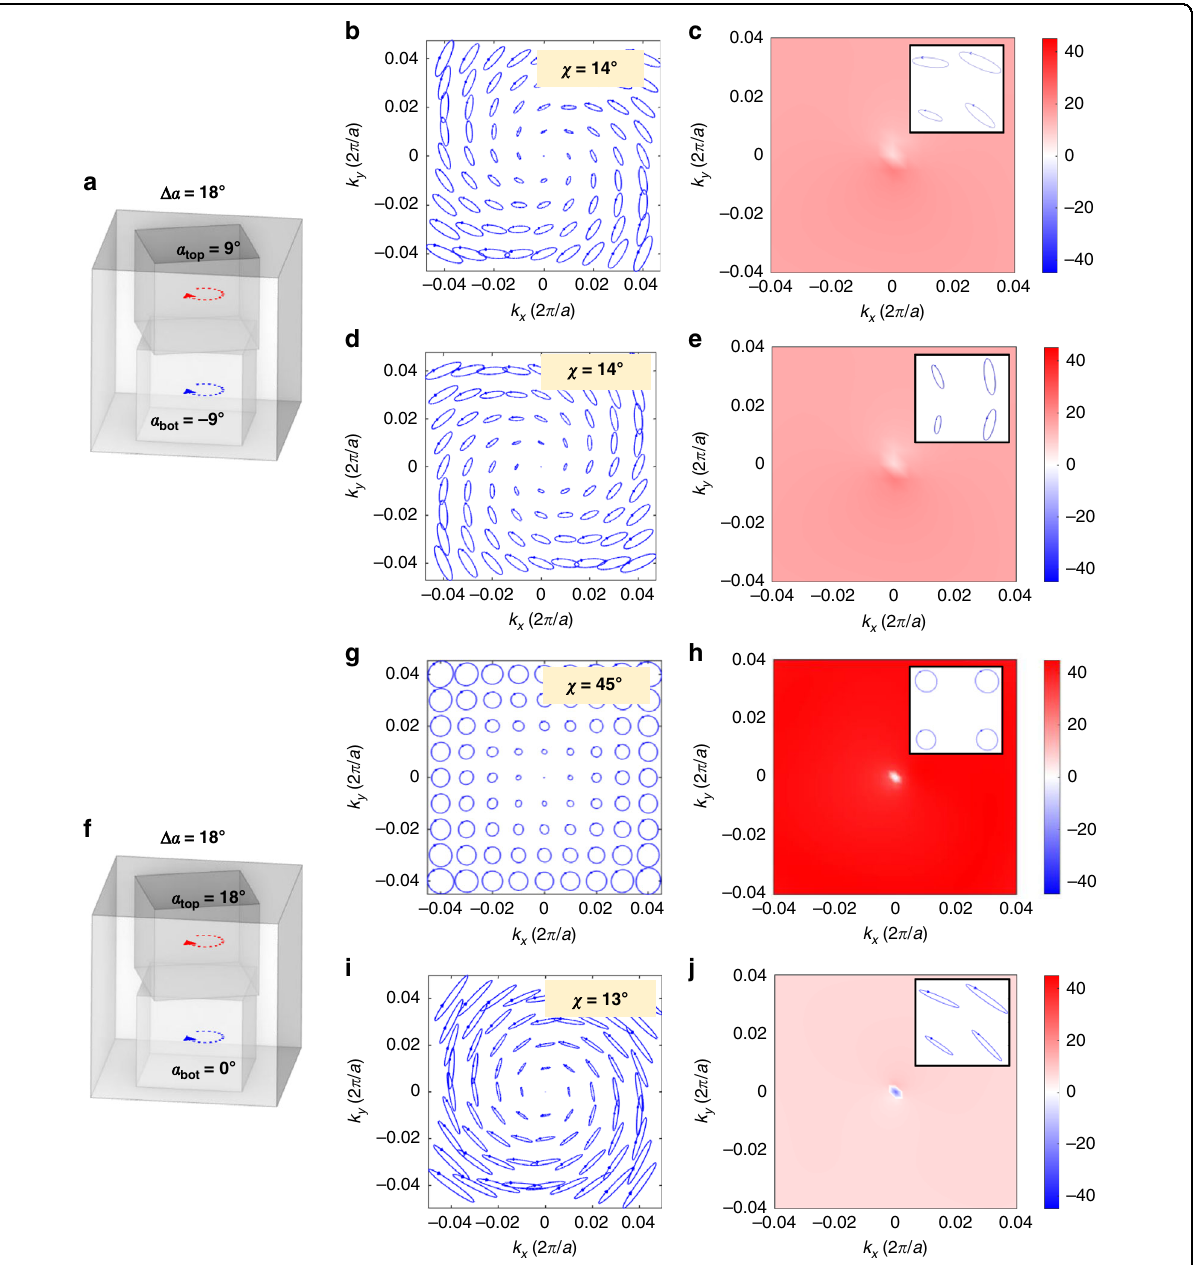
Fig. 5 Comparison of far- fi eld polarization states in momentum space of two twisted PhCSs supporting BIC with the same relative angle between top and bottom layer Δ α = α top − α bot = 18°. a Schematic of the structure with point symmetry against the center of the PhCS at = 9° and α = − 9°. Distribution far- fi eld polarization states in ( b ), c upward and d , e downward radiation, showing the same χ distribution. α top bot f Schematic of the PhCS with the same relative angle of Δ α = 18° but the different absolute angle of α top = 18° and α bot = 0°. g distribution of upward far- fi eld polarization states shows circularly polarized radiation at every point in vicinity of BIC. h The ellipticity angle ( χ ) of polarization states in ( g ) is 45° indicating circular polarization. i Polarization states of downward radiation. j The ellipticity angle is 13°, different from upward radiation. Insets in ( h ), j show the enlarged view of polarization far- fi eld polarization gradually changes from C points to L ranging within a span of 90°. This trend can be under- lines. A similar trend holds true for negative α stood in view of the square ’ s four-fold rotation symmetry that top and the difference of polarization angles induced by the covers the polarization states on the lower hemisphere. two equivalent scatters. The Poincaré sphere can be covered twice with α top